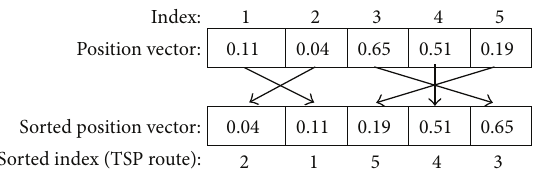
Figure 1: A sample random key